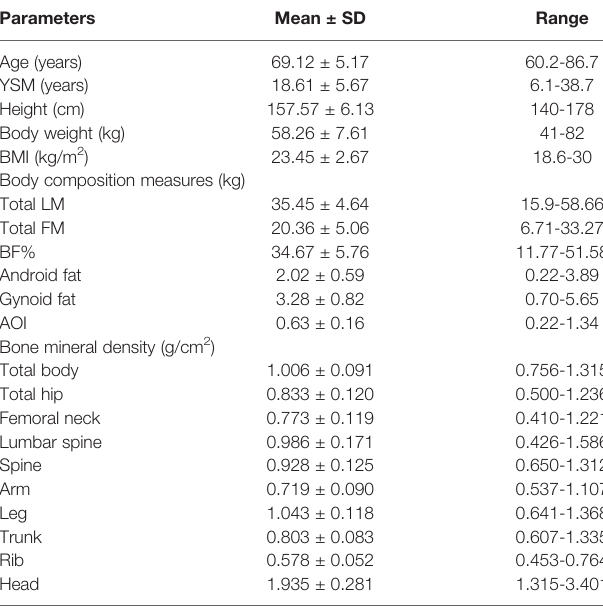
TABLE 1 | Baseline characteristics of subjects.